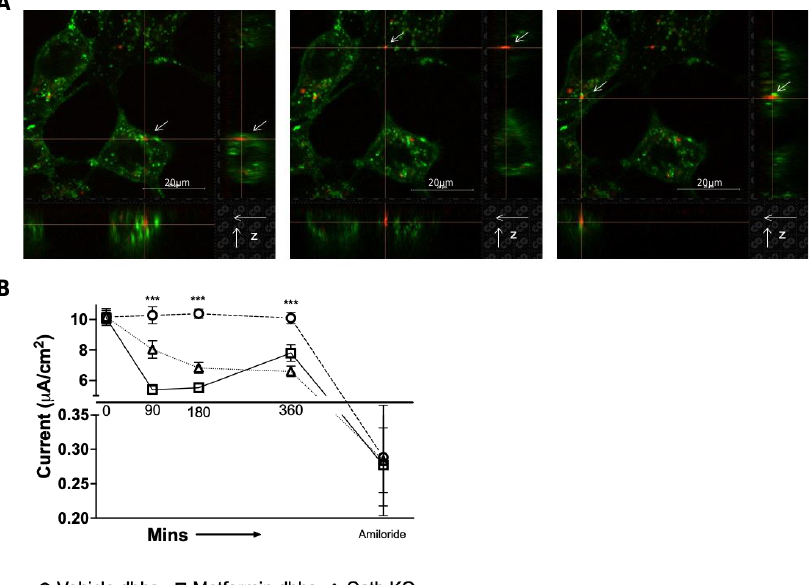
Figure 7. Uptake of urinary EVs from diabetic db/db mice by mouse mpkCCD cells and changes in amiloride-sensitive transepithelial current after mpkCCD cells were challenged with urinary EVs from vehicle- or metformin-treated db/db mice on an HSD. ( A ) Immunofluorescence images of mp- kCCD cells (green, orthogonal view) treated for 15 min with red fluorescently labeled urinary EVs isolated from diabetic db/db mice. ( B ) Amiloride-sensitive transepithelial current